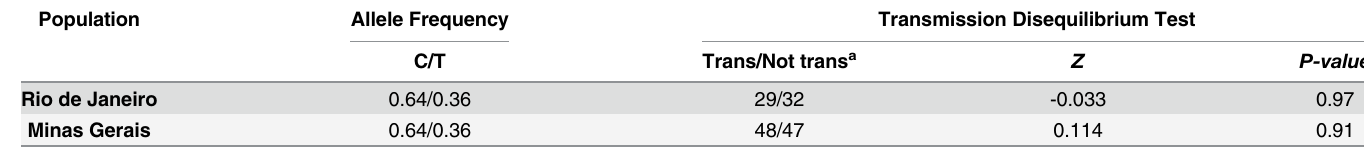
Table 2. Summary of the results from the family-based association studies with -819 C > T (rs1800871) and association with leprosy.